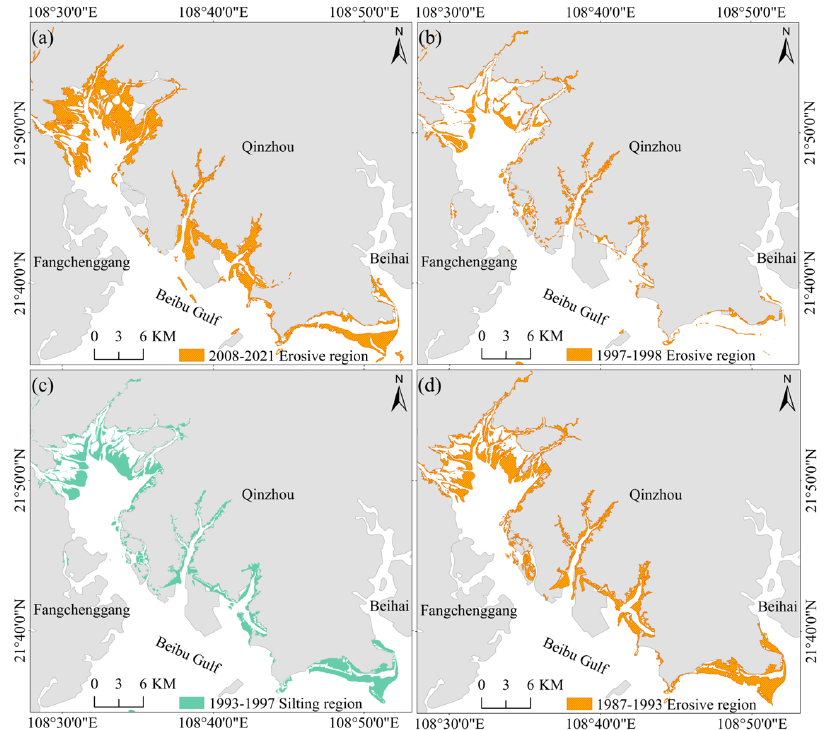
Figure 13. Spatio-temporal siltation erosion distribution of tidal flats in Qinzhou shore section. ( a ) Erosion distribution of tidal flats in Qinzhou shore section from 2008 to 2021. ( b ) Erosion distribu- tion of tidal flats in Qinzhou shore section from 1997 to 1998. ( c ) Siltation distribution of tidal flats in Qinzhou shore section from 1993 to 1997. ( d ) Erosion distribution of tidal flats in Qinzhou shore section from 1987 to 1993.